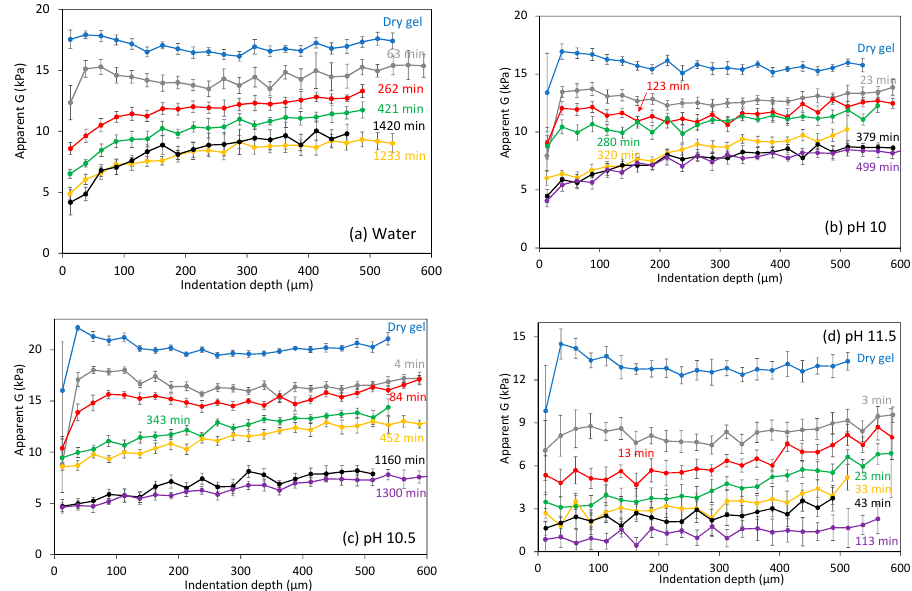
Figure 4. Calculated apparent shear modulus at different indentation depths in gels swollen at different conditions for different times. Dry gels refer to gel as prepared, i.e., before being submerged in solution. Points are the mean value of three indentations at different locations, error bars show the standard error. Note that as Equation (1) is only valid for homogeneous samples, G estimates with depth can only highlight qualitatively if substantial mechanical inhomogeneity occurs in the tested swollen layer.